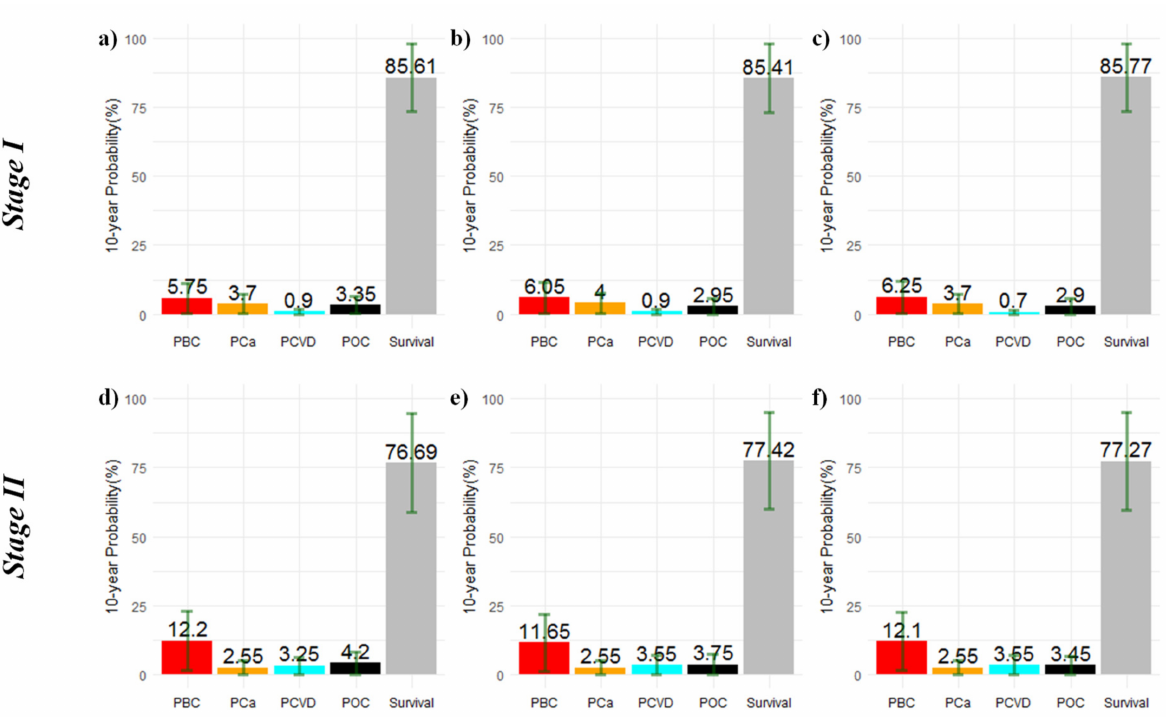
Figure 1. Cause-specific 10-year cumulative probabilities of death and probability of survival beyond 10 years after breast cancer diagnosis in Stages I–II. Panels show the results stratified by age group for the whole cohort: ≤ 49 ( a , d ), 50–68 ( b , e ), and ≥ 69 years ( c , f ). Note: vertical lines in dark green represent the standard deviation of the probability